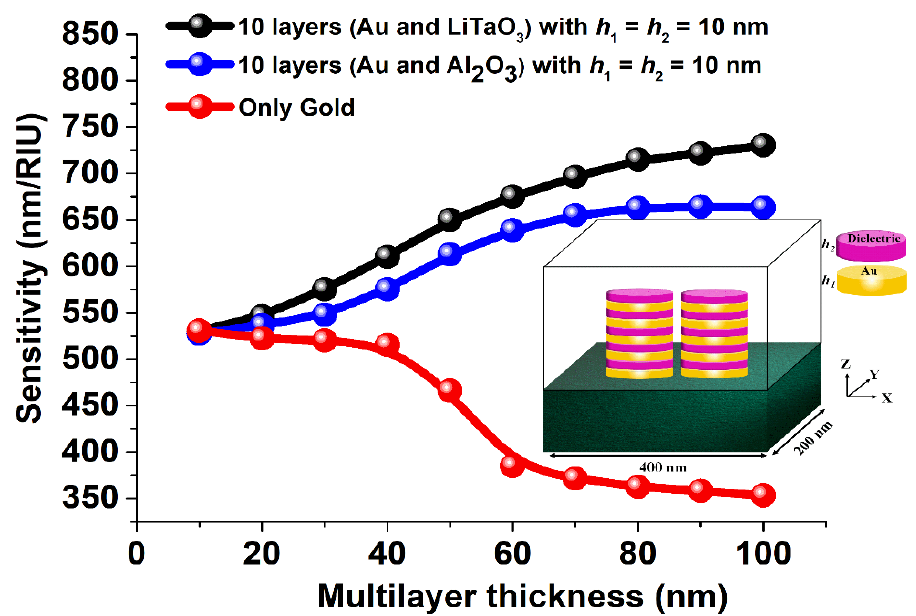
Figure 3. The sensitivity performance of a single metallic (Au) and Al 2 O 3 and LiTaO 3 stacked antenna array when total height, h = 100 nm with or without stacking.